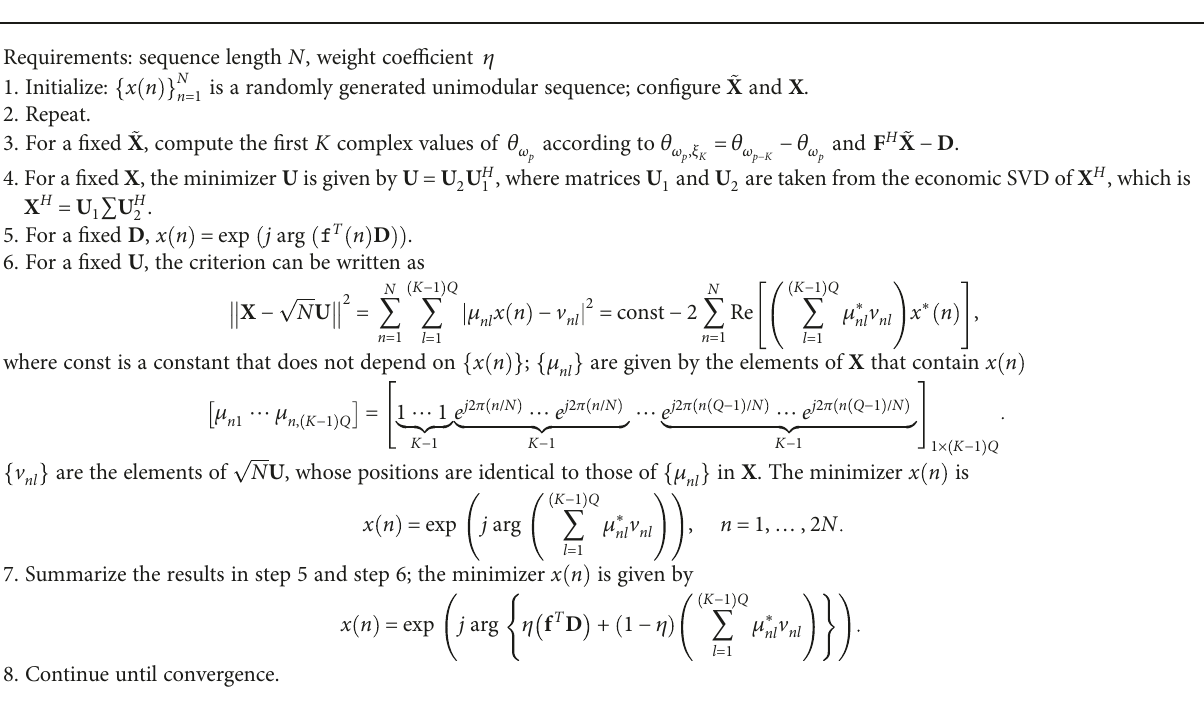
, f , f , and f in Appendix D ( N = 50 , and the fi rst K phases of the frequency are random) 1 2 3 4